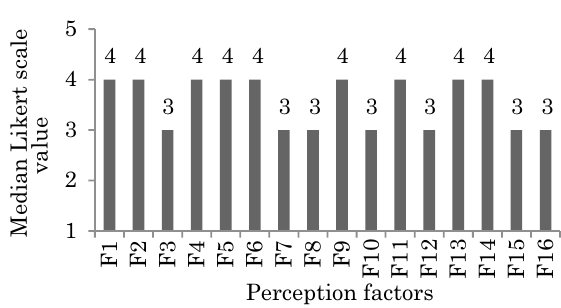
fig. 2. Median perceptions of flood plain